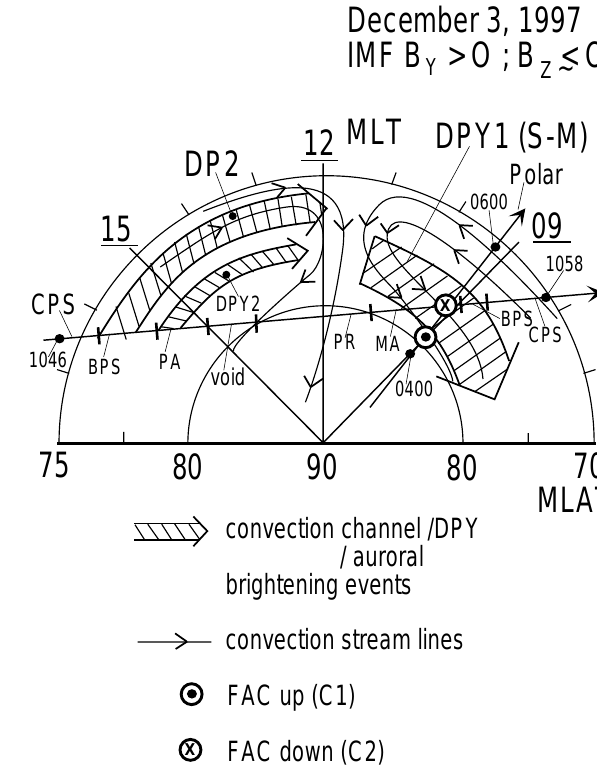
Figure 13 Fig. 13. Schematic illustration of equivalent convection in MLAT/MLT coordinates for IMF B z < 0; B y > 0 conditions, as de- rived from the IMAGE chain X component magnetic deflections on 3 December 1997. Three regions of strong magnetic deflec- tion are marked by arrows with hatching. They are labelled DP2 (strongest effect seen in the postnoon sector), DPY1 (the Svalgard- Mansurov effect; strongest in the prenoon sector), and DPY2 (post- noon sector). Trajectories of spacecraft DMSP F13 during the inter- val 10:46–10:58 UT and Polar during the interval 04:00–06:00 UT are